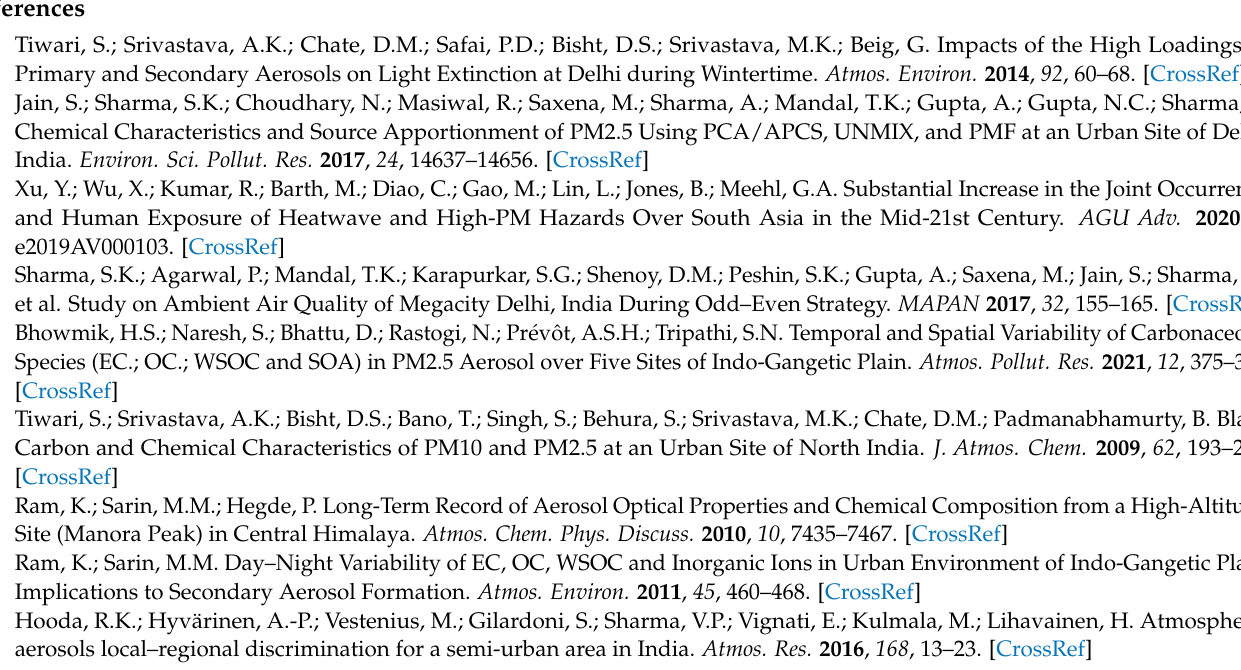
site. Table S1: Results of BS, DISP, and BS-DISP error estimates and Table S2: shows the seasonal average mass concentration ( ± 1 σ ) of total suspended particle and chemical constituents at Nainital during February 2005–February 2008. The values in parenthesis are ± 1 σ